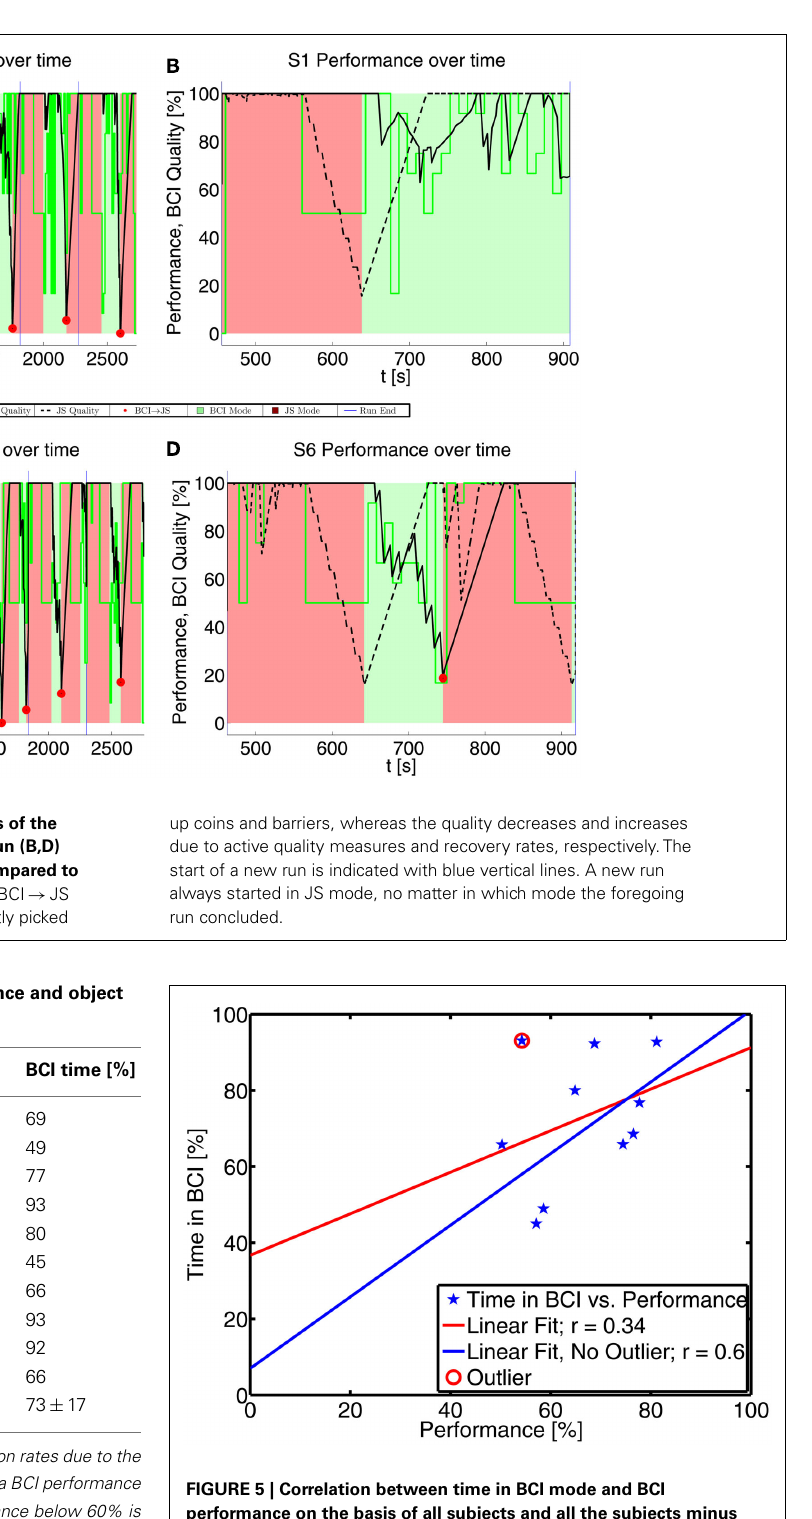
FIGURE 5 | Correlation between time in BCI mode and BCI performance on the basis of all subjects and all the subjects minus one outlier (highlighted